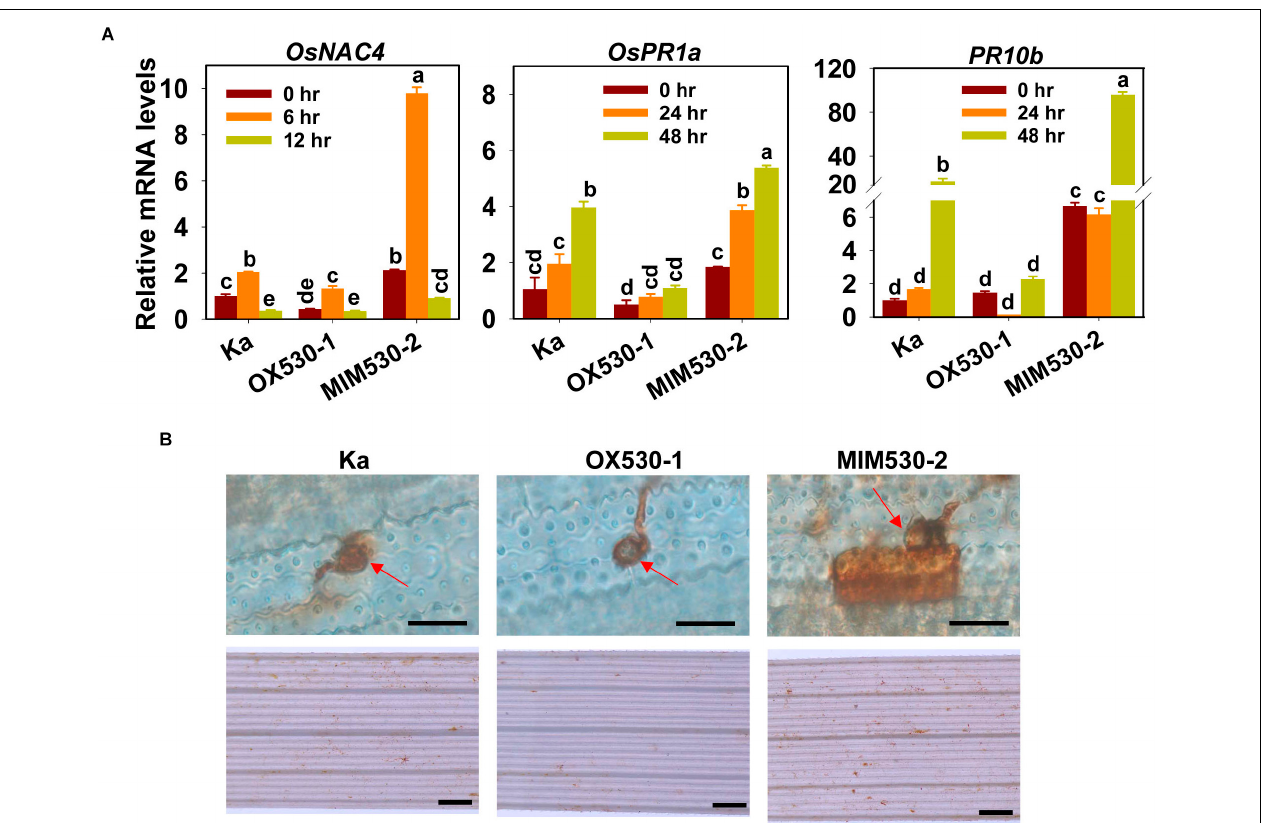
FIGURE 3 | miR530 regulates Magnaporthe oryzae -induced defense responses. (A) The relative mRNA levels of the defense-related genes ( OsNAC4 , OsPR1A , and OsPR10b ) in the Kasalath controls (Ka) and the indicated lines at the indicated time points. The data are shown as mean ± SD ( n = 3 independent samples). The mRNA levels were normalized to that in the indicated control. Different letters above the bars indicate significant differences ( P < 0.01) as determined by the one-way ANOVA analysis. (B) The hydrogen peroxide (H 2 O 2 ) accumulation in the Kasalath controls and indicated lines at 48 h postinoculation of M. oryzae strain Guy11. The accumulation of H 2 O 2 was stained by 3,3 (cid:48) -diaminobenzidine (DAB), and the intensity of brown indicates the amounts of H 2 O 2 . The red arrows indicate appressoria formed from conidia. The photographs given above were taken with the leaves using a microscope (Zeiss imager A2, Germany). Scale bars = 10 µ m. The photographs given below were taken with the leaves with a stereomicroscope (Zeiss imager A2, Germany). Scale bars = 50 µ m. These experiments were repeated two times with similar results.